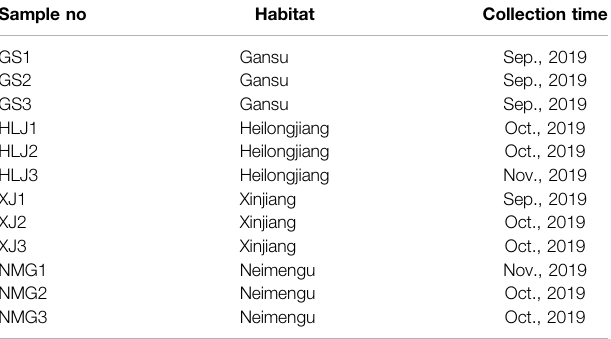
TABLE 1 | Sample collection information of the dried root of Isatis indigotica .